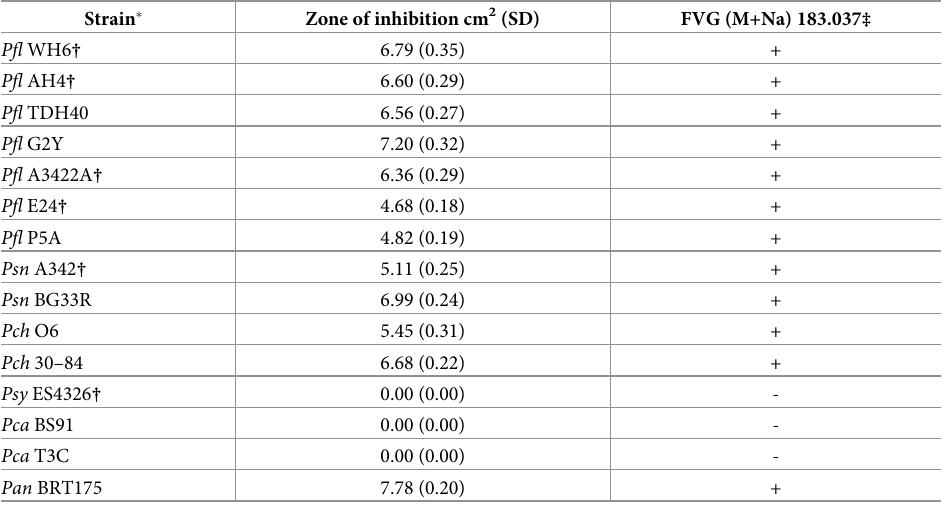
Table 2. Zone of inhibition of bacterial filtrates against Erwinia amylovora and detection of FVG (m/z 183.037) by LAESI-MS for various